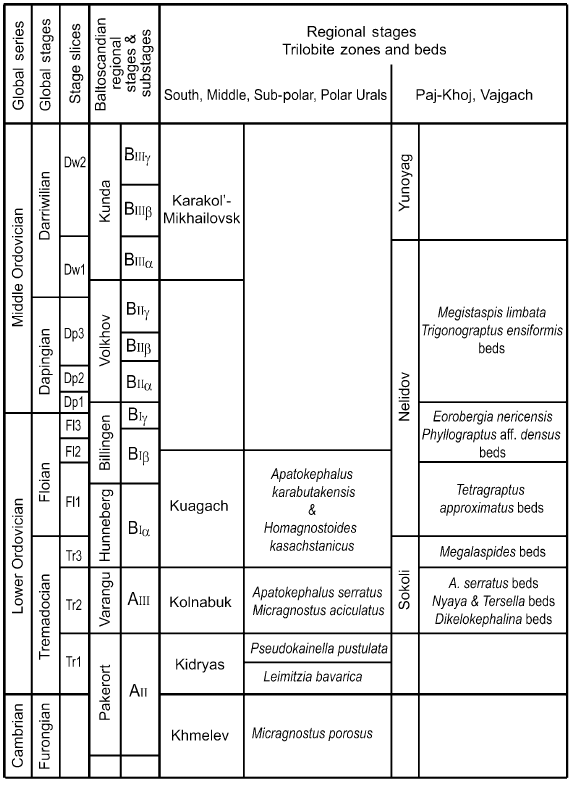
Fig. 6. Correlation of regional stages and trilobite zones of the Urals with Baltoscandian and global chronostratigraphy. The faunal zonation of the Urals follows that in Antsygin (1977, 2001) and Puchkov (1991), and of Paj-Khoj and Vajgach that in Burskij (1970). For legend see Fig.